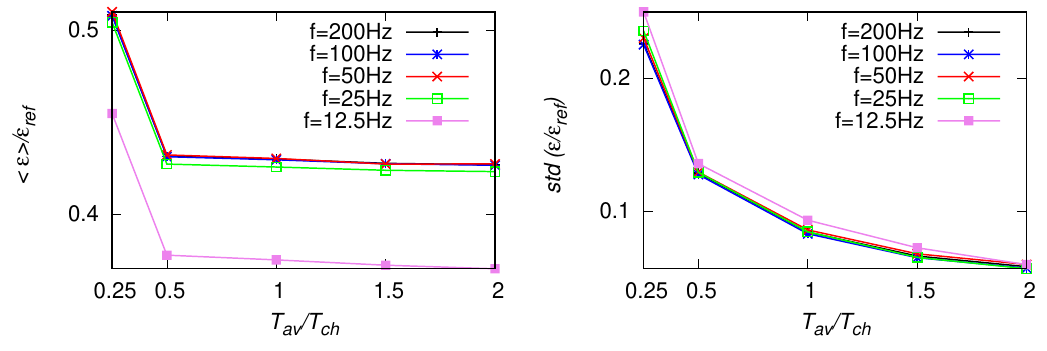
Figure 12. As in Figure 10, but for the fitting range f = [ 1 ÷ 5 ] Hz.